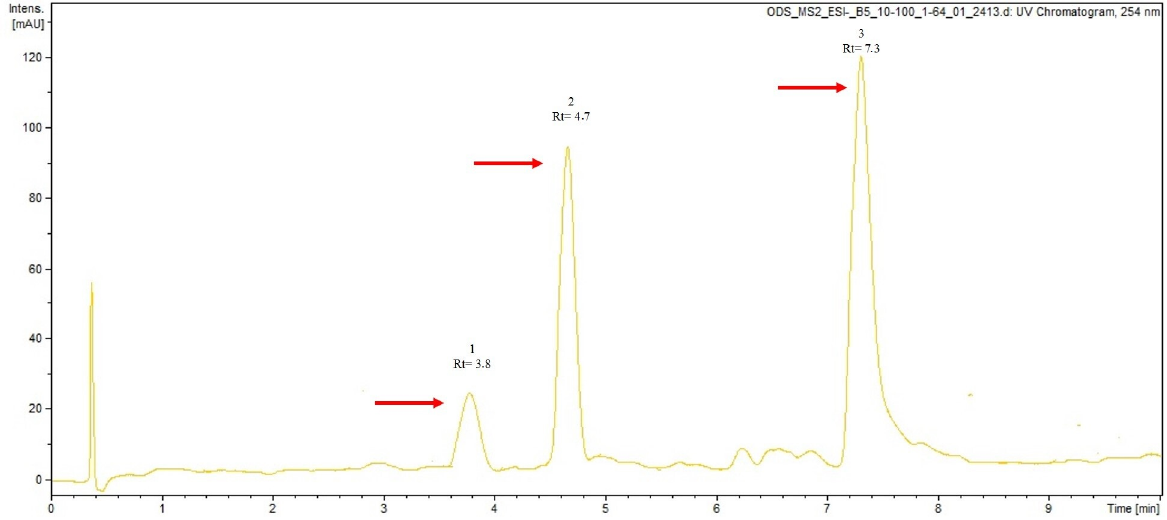
Figure A3. Chromatograms (UV 254 nm) of EtOAc extract of A. stygium WL1B5 by LC-MS/MS and the three major peaks at 3.8 (C1), 4.7 (C2) and 7.3 (C3) min. During the research in the literature for information on the peak eluting at 4.7, no equivalent mass compounds were found.